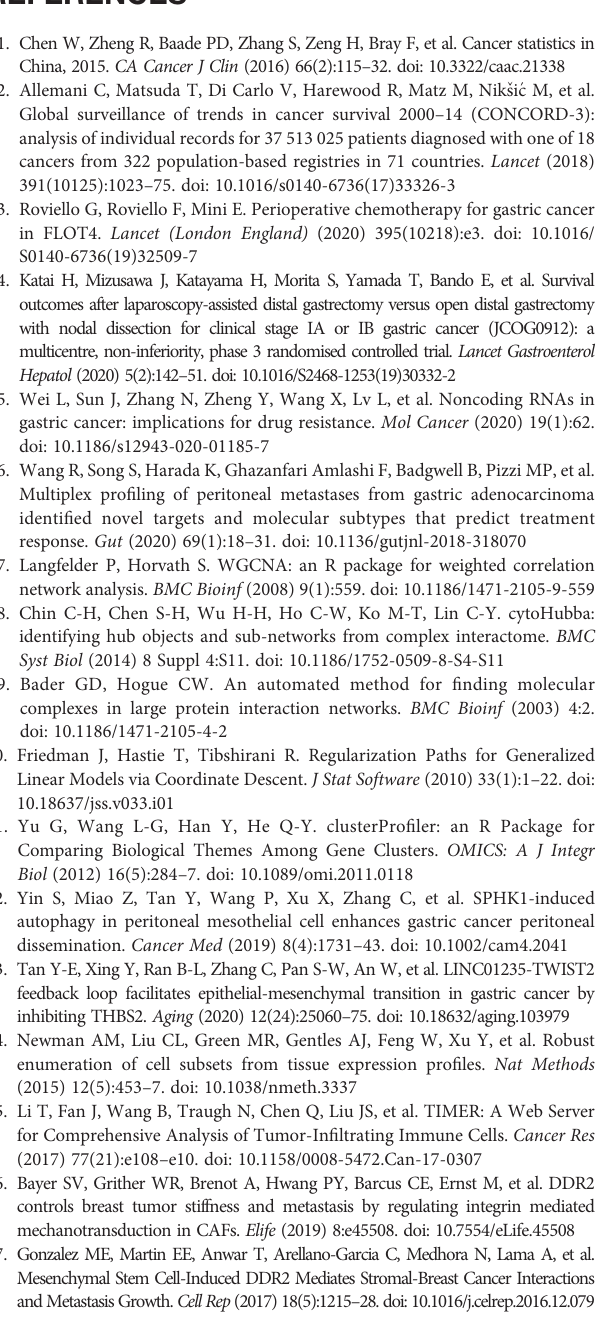
Supplementary Figure 1 | (A) Sample cluster dendrogram. Red line represents height of 31. (B) Analysis of scale-free independence and mean connectivity to